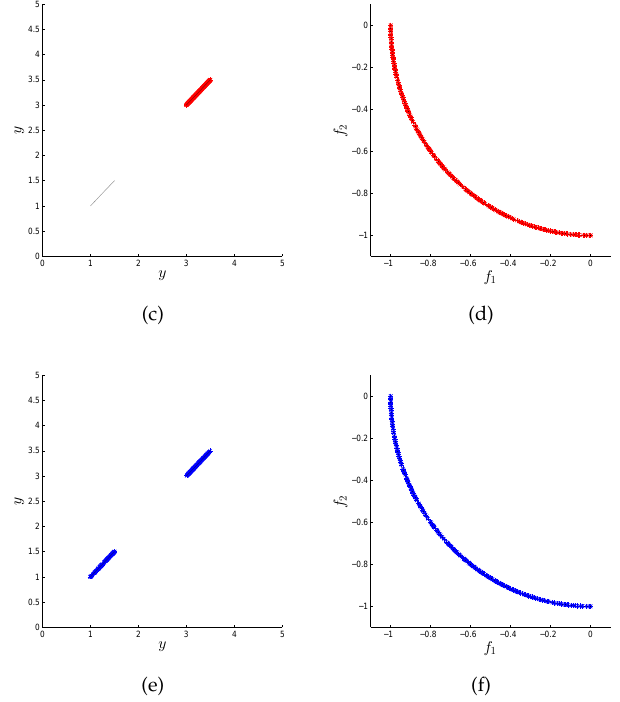
Figure 5. Graphical results of the run with the median values for the OMNI2 function for the NSGA-II algorithm. ( a ) Decision Space Original; ( b ) Objective Space Original; ( c ) Decision Space VR; ( d ) Objective Space